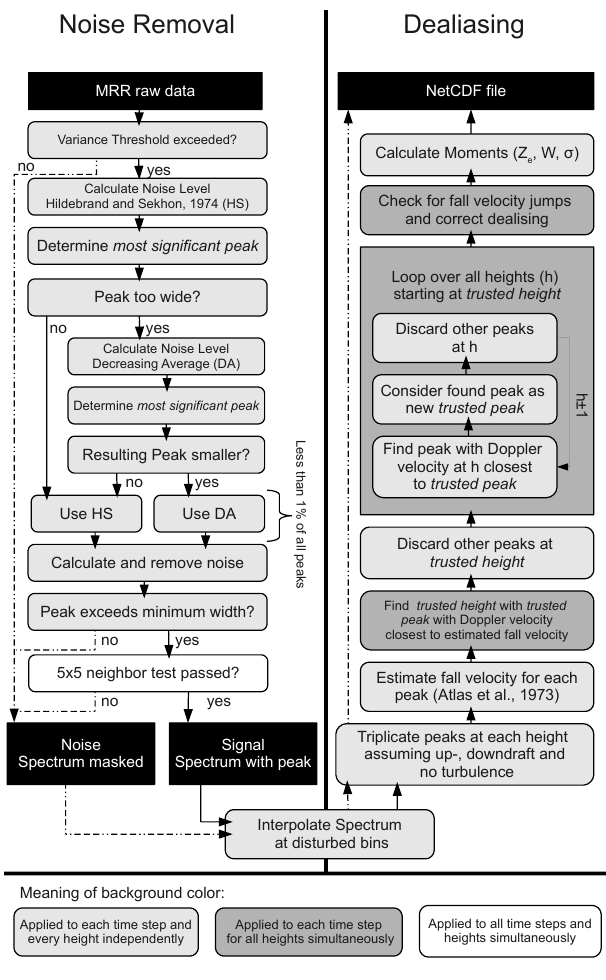
Fig. 5. Flow chart diagram of noise removal and dealiasing of the proposed MRR processing